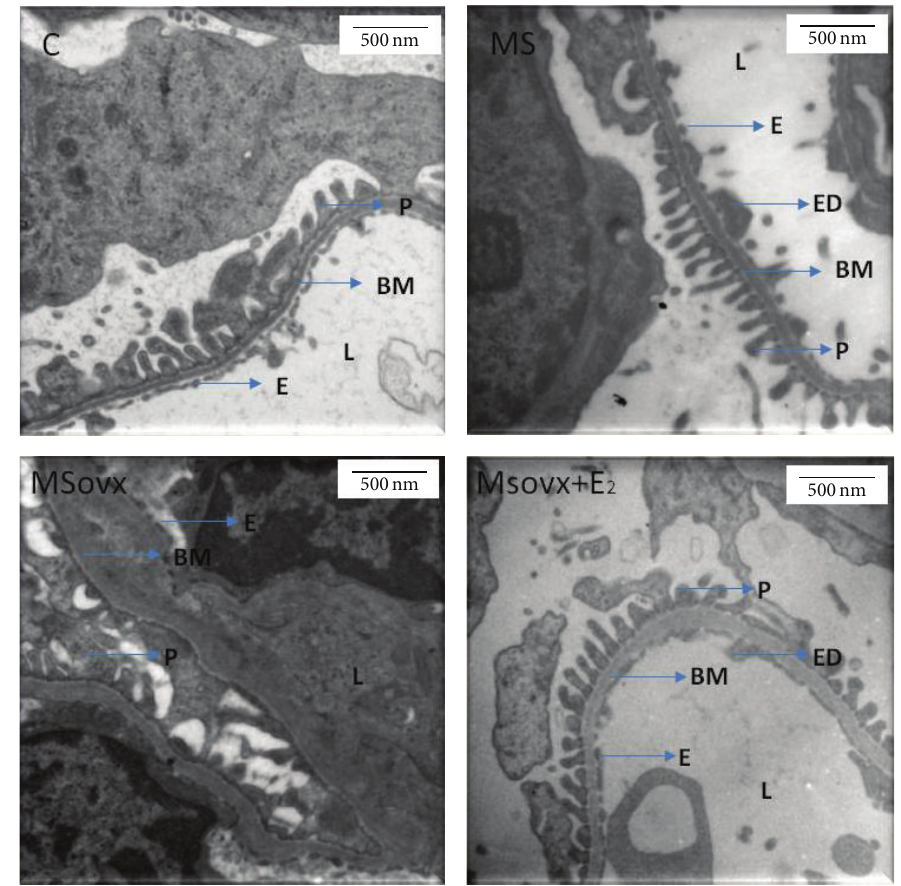
Figure 6: Representative micrographs of electron microscopy of renal capillary loops (20000x). C rats, no abnormalities are found. The images from MS and MSovx rats show abnormalities in basal membrane with endothelial edema and filiform podocyte in some zones. The images from the MSovx + E 2 rats show abnormalities in basal membrane with remodeling and thickness variability; the podocyte processes have almost disappeared and the fenestrated endothelium is lost or obliterated in many areas. C: control, MS: metabolic syndrome, MSovx: metabolic syndrome ovariectomized, MSovx + E 2 : metabolic syndrome ovariectomized plus estradiol, BM: basal membrane, E: endothelium, ED: edema, L: lumen, and P: